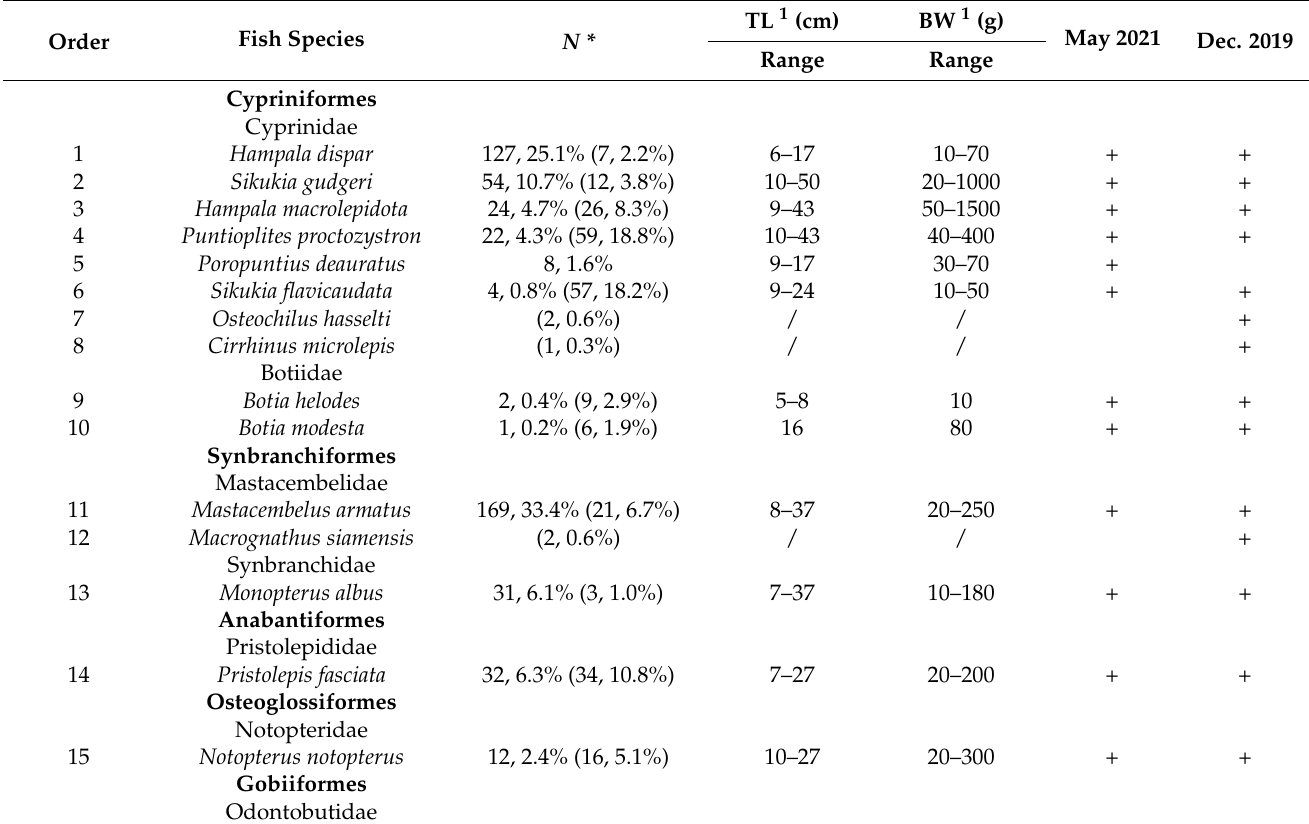
Table 2. Fish composition and biological characteristics in the